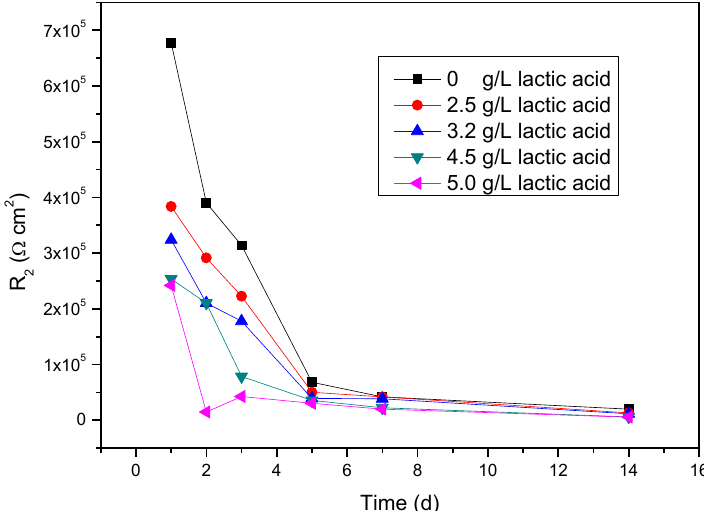
Figure 6. R of titanium immersed in artificial saliva containing different amounts of lactic acid. 2